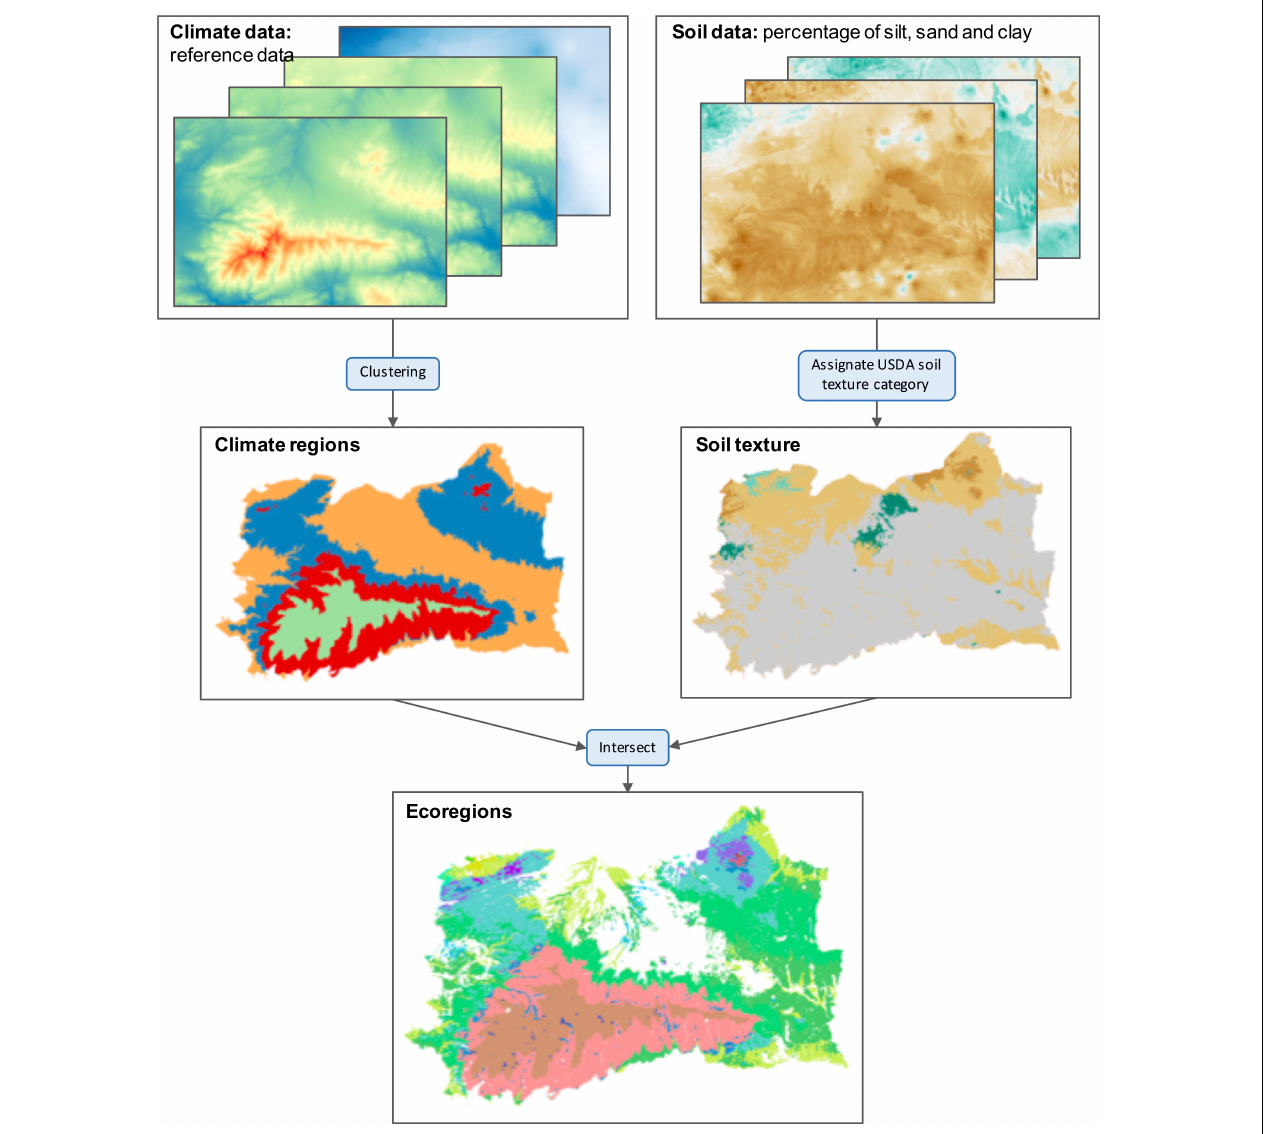
FIGURE 3 | Schematic view of workflow followed to produce the ecoregions map. Reference climate data consist of annual precipitation, mean, minimum and maximum annual temperature for the period 1971–2000 at 100 m resolution. Clustering of climate data resulted in four climate regions. Soil data consist of a percentage of silt, sand and clay at 250 m resolution. The intersection of climate regions and soil textures resulted in 27